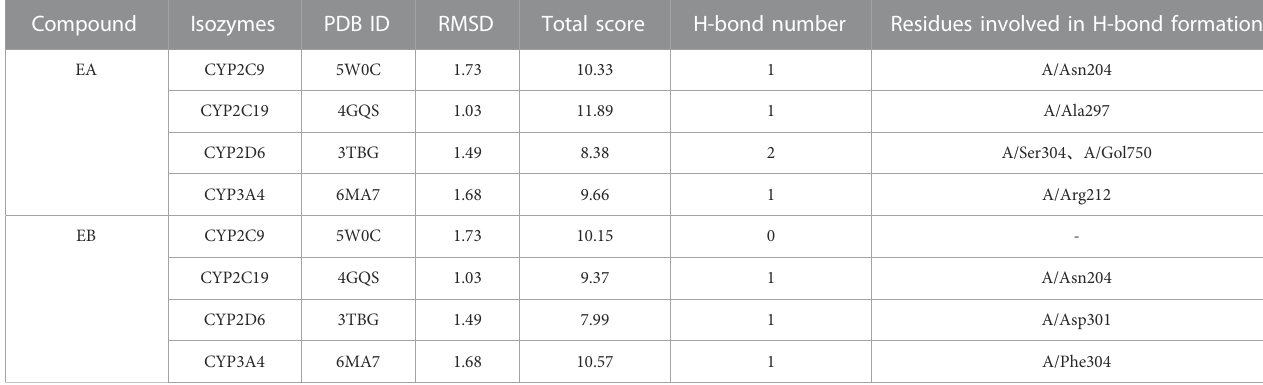
TABLE 4 Interactions between EA or EB and CYP isozymes by molecular docking.